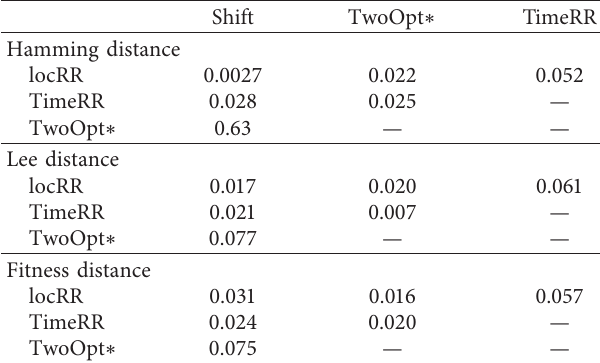
Table 5: Adjusted P values for every pair of heuristics in vehicle